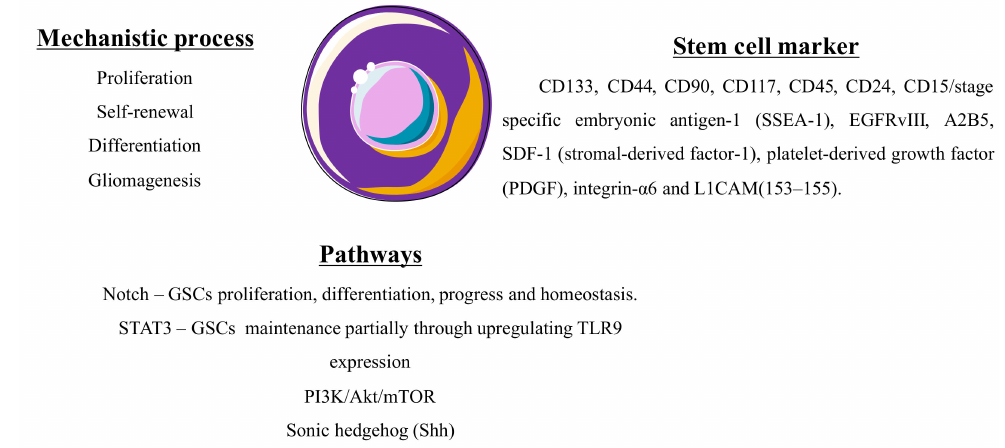
Figure 5. Glioma stem cells (GSCs) mechanistic process, including proliferation, self-renewal, multidifferentiation and tumorigenic capability, and possible surface markers/pathways for targeting approaches